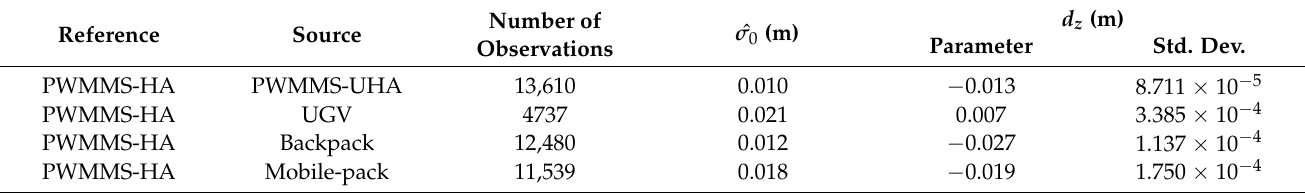
Table 8. Estimated vertical discrepancy ( d z ) and square root of a posteriori variance ( ˆ σ 0 ) using B-1 (PWMMS-HA), B-2